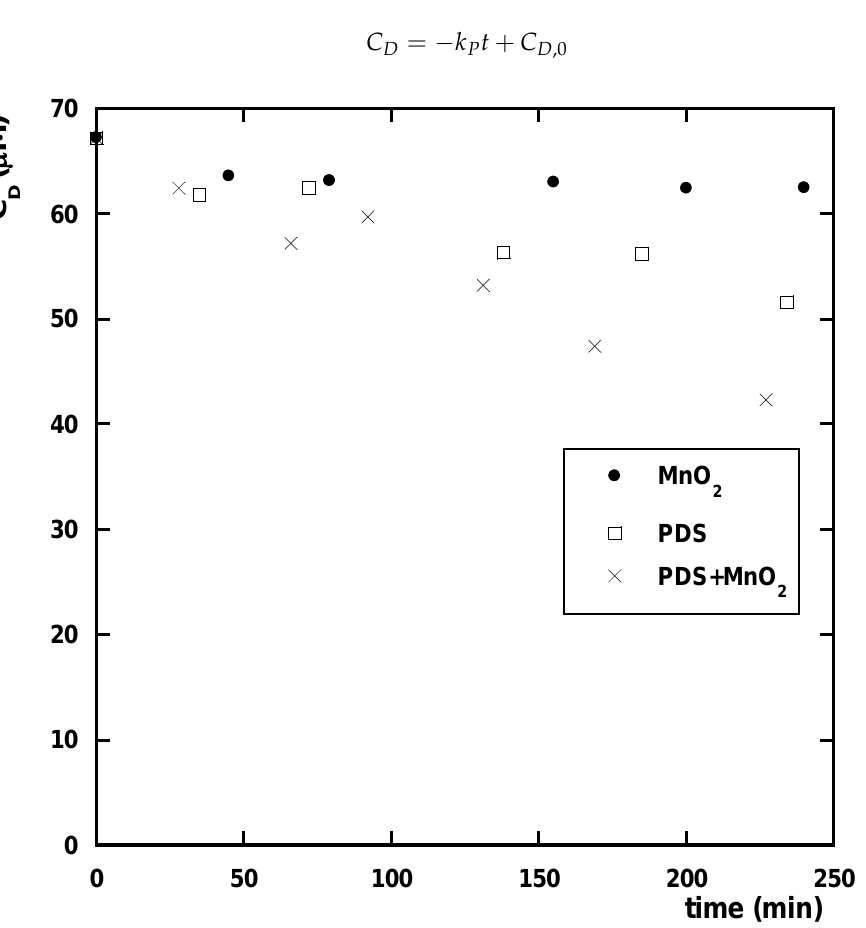
Figure 8. Diuron degradation kinetics profiles in the presence of MnO 2 (2.4 g L − 1 ), in the presence of PDS (4.5 g L − 1 ), and in their co-presence; T = 30 ◦ C.